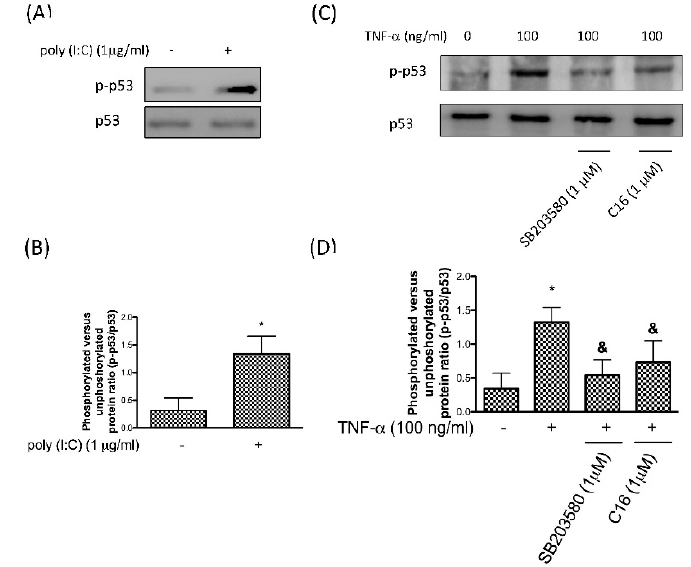
Figure 2. Protein expression ( A ) and the ratio ( B ) of p-p53 after upregulation of PKR using poly (I:C); Protein expression ( C ) and the ratio ( D ) of p-p53 following TNF- α exposure in human chondrocytes in the presence or absence of p38 inhibitor SB203580 or PKR inhibitor C16 ( n = 3; * p < 0.05 compared to control group. p < 0.05 compared to TNF- α group, p values were generated by ANOVA using the Tukey’s test).